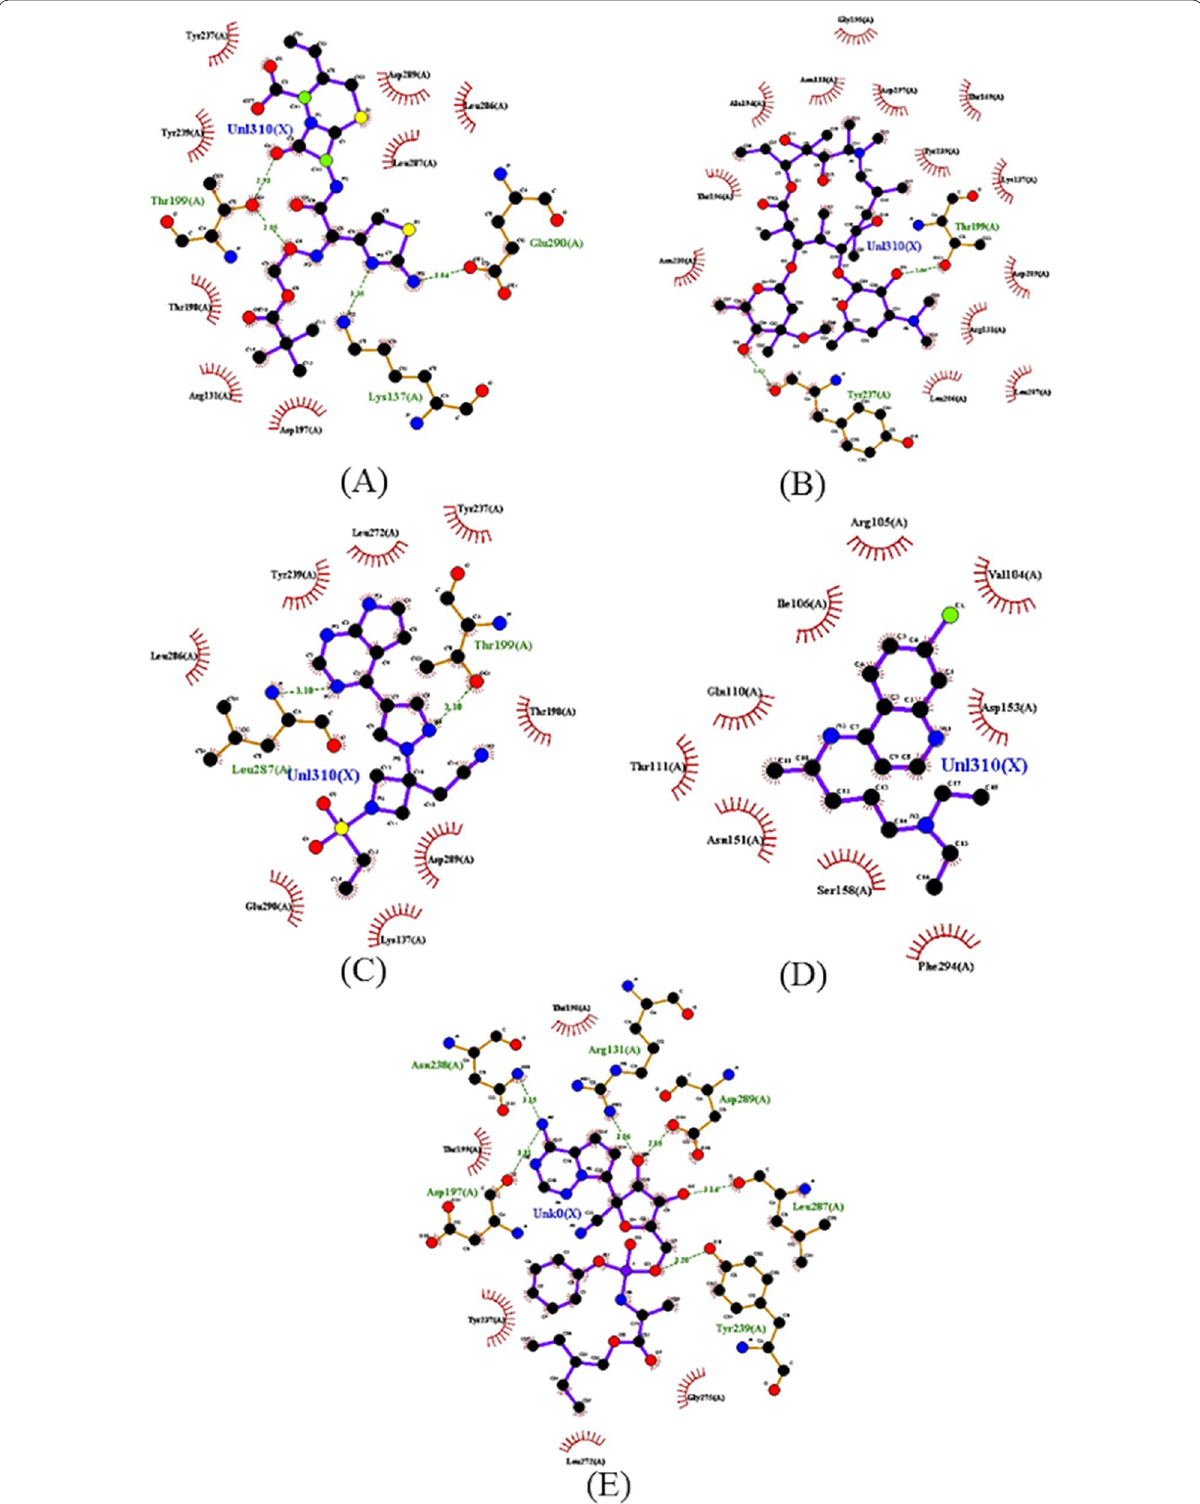
Fig. 5 2D map representative of H-bonds between control ligands and Mpro SARS-CoV-2. A Anakinra, B azithromycin, C baricitinib, D chloroquine e E